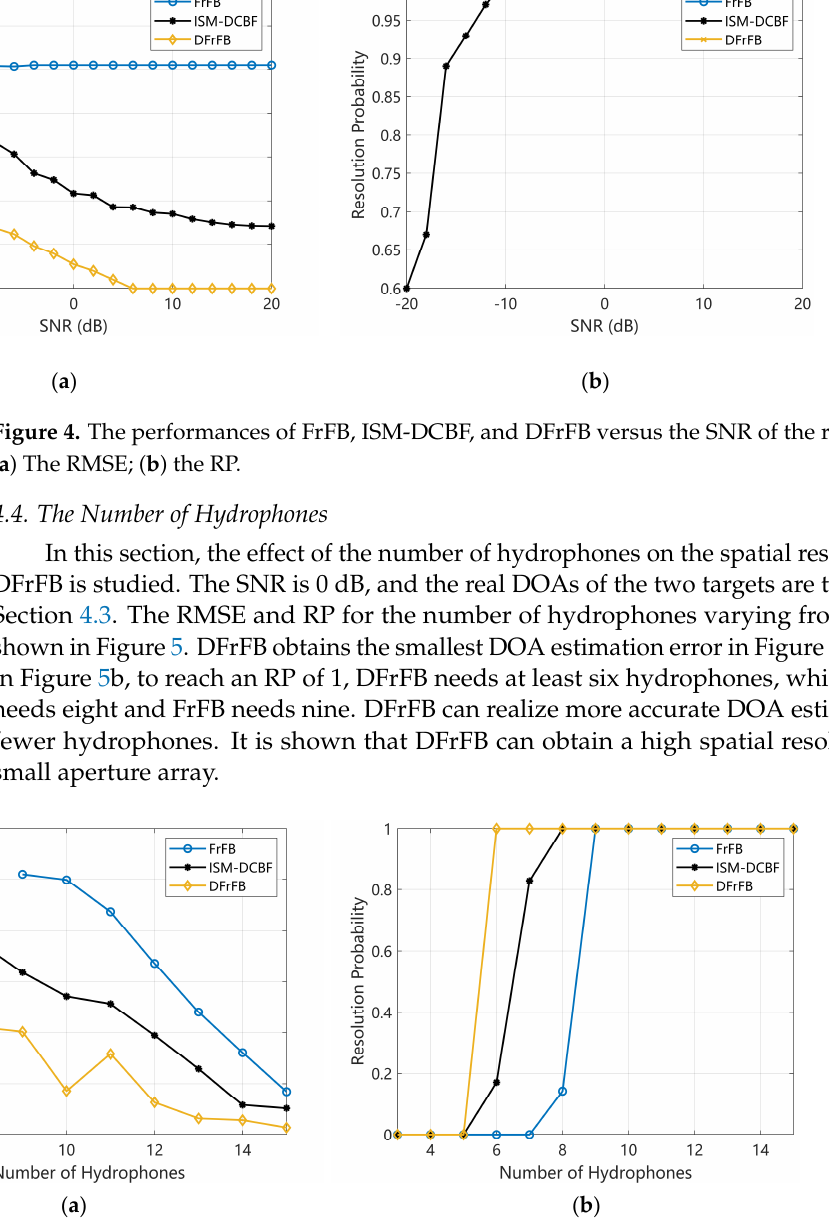
Figure 5. The performances of FrFB, ISM-DCBF, and DFrFB versus the number of hydrophones. ( a ) The RMSE; ( b ) the RP. ( a ) The RMSE; ( b ) the